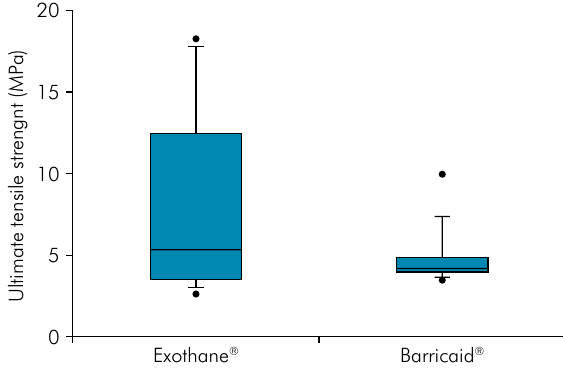
Figure 3. Ultimate tensile strength for Exothane-based and Barricaid ® periodontal dressings. There were not statistically significant differences among the materials (p = 0.063).